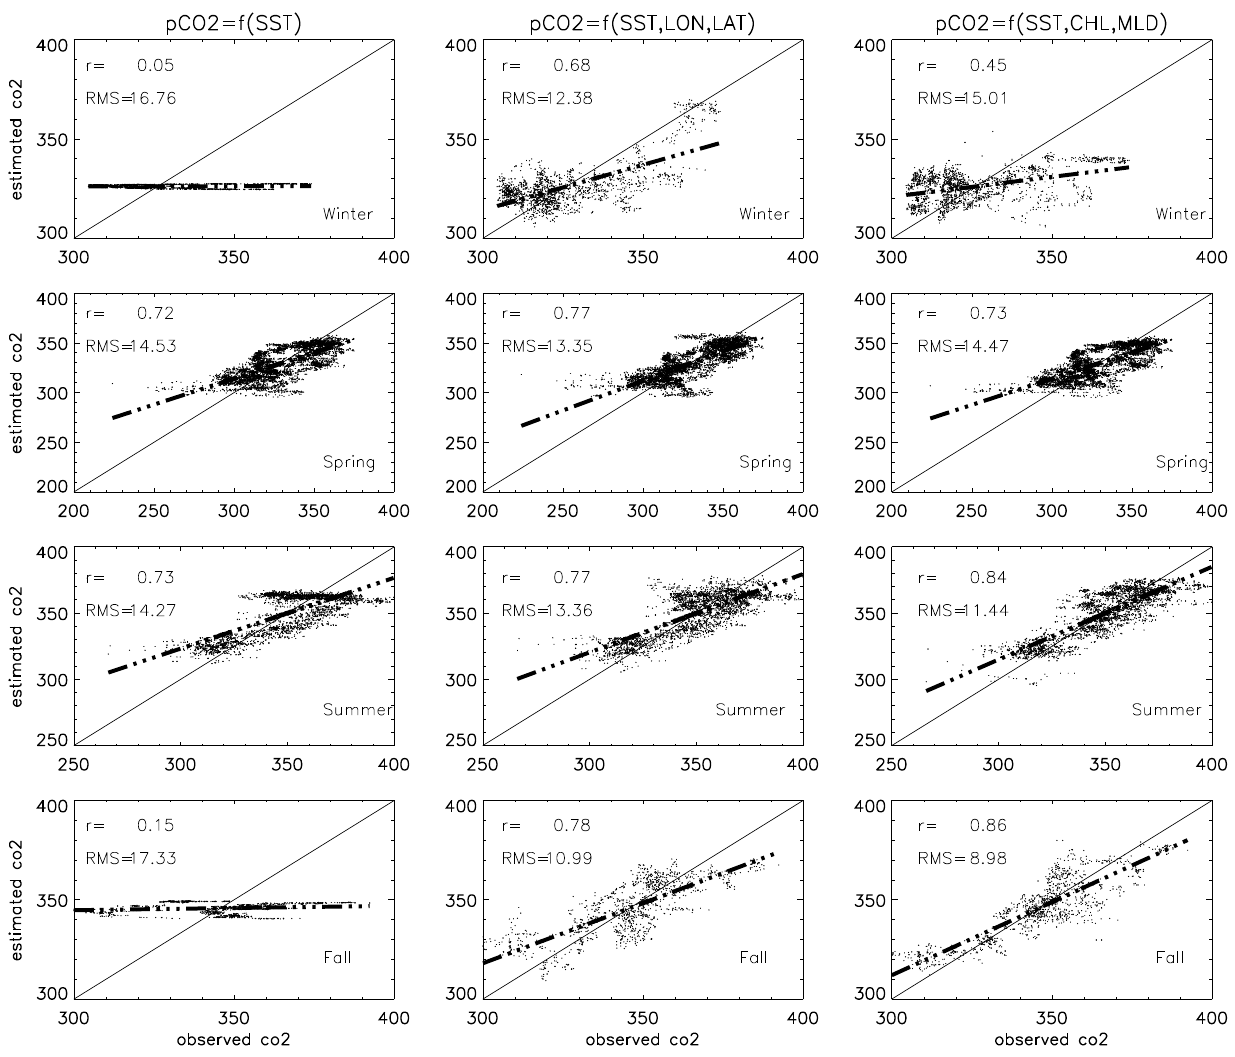
Fig. 2. Scatterplots of the in-situ pCO 2 vs. estimated pCO 2 obtained by three linear regressions based on the training data set: Left column pCO 2 = f (SST) (Eq. 2); middle column: pCO 2 = f (SST, longitude, latitude) (Eq. 4), right column: f (SST, CHL, MLD) (Eq. 3) for winter, spring, summer and